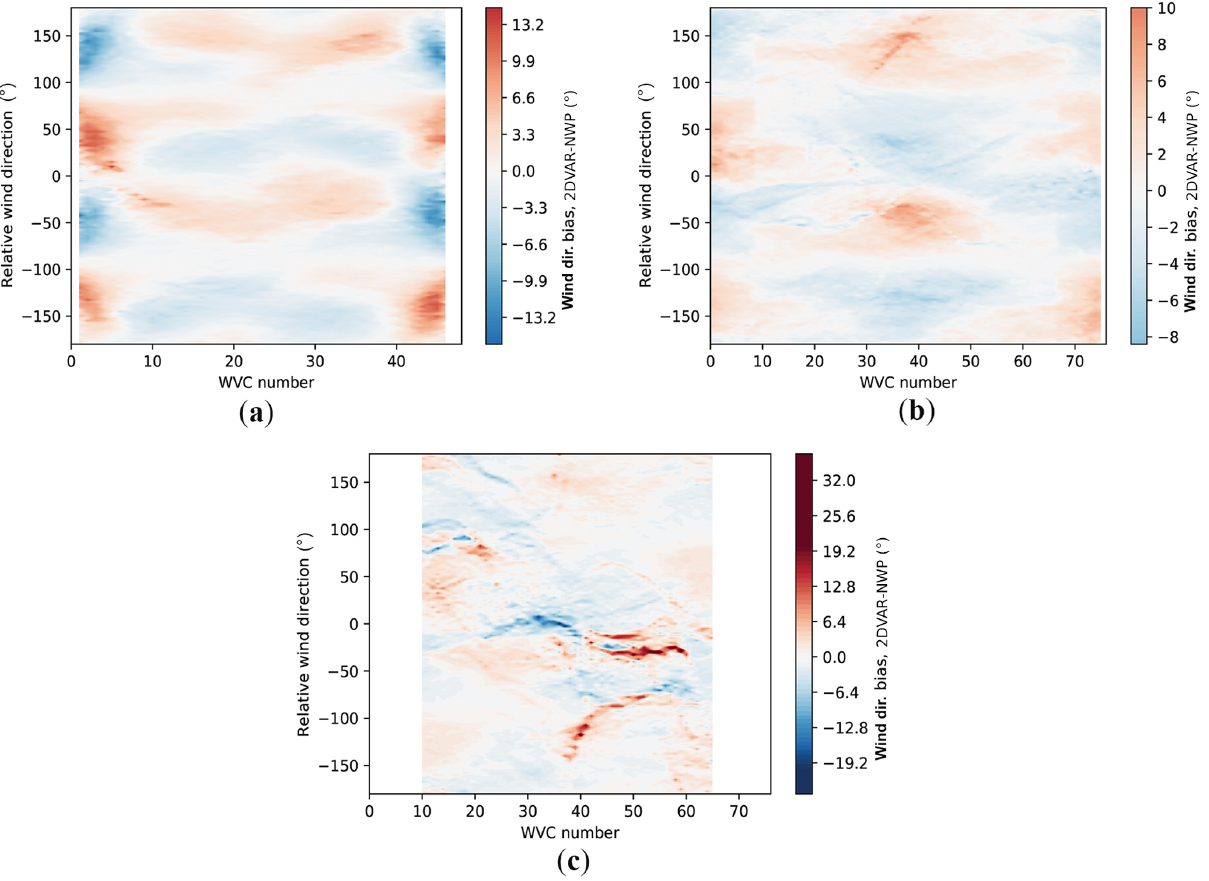
Figure 22. Wind direction bias between wind retrieval result and true wind as a function of WVC number and the relative wind direction. (The y axis is the retrieved wind direction relative to the satellite motion direction. The color scale is consistent for easy comparison; all the values outside [ − 20, 20] are marked as dark blue and dark red.) (a) SCAT. (b) SeaWinds. (c)